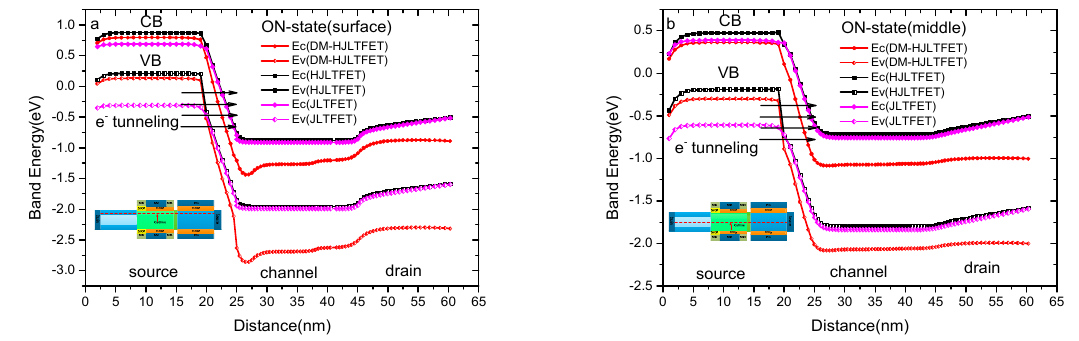
Figure 3. ( a ) The energy band diagram of JLTFET, HJLTFET and DMMG-HJLTFET at the device surface region; ( b ) The energy band diagram of DMMG-HJLTFET at the device middle region.